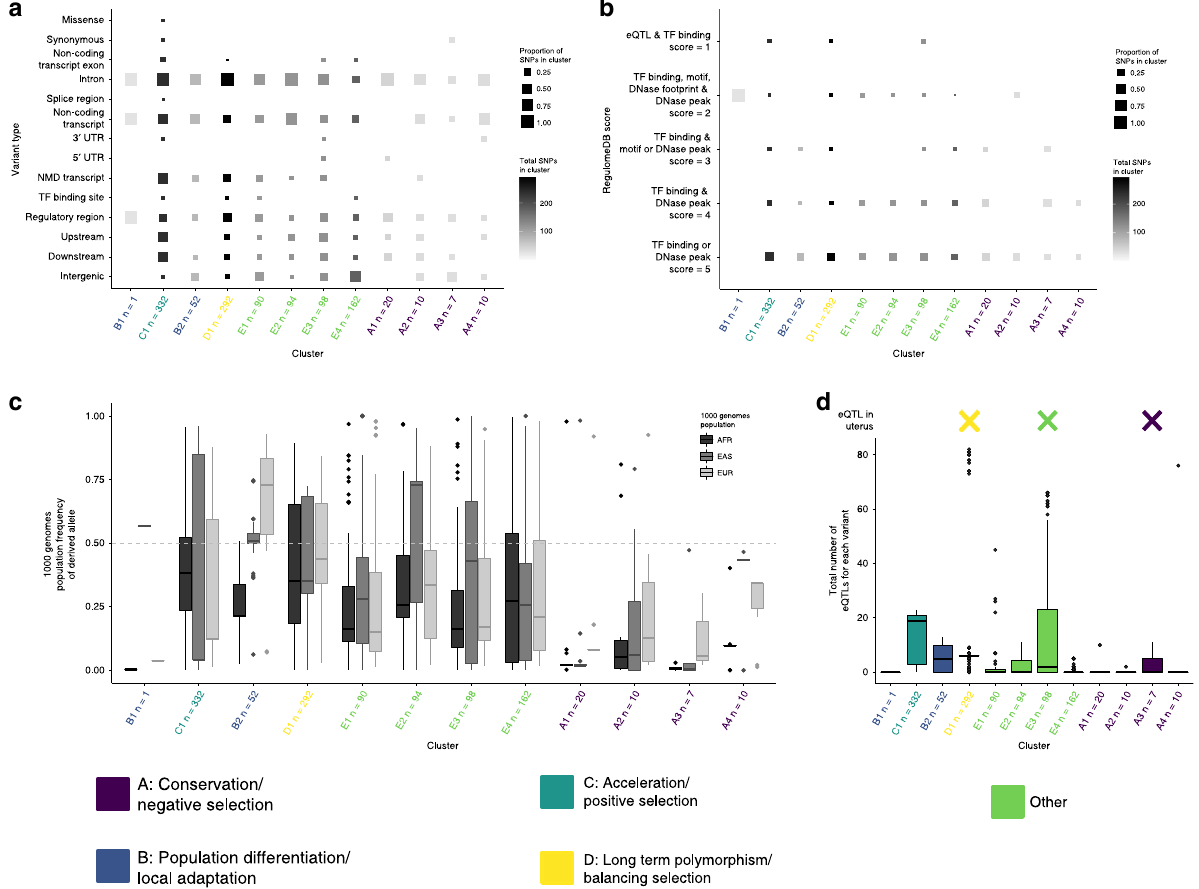
Fig. 3 Groups of sPTB regions vary in their molecular characteristics and functions. Clusters are ordered as they appear in the z-score heatmap (Fig. 2) and colored by their major type of selection: Group A: Conservation and negative selection (Purple), Group B: Population differentiation/local adaptation (Blue), Group C: Acceleration and positive selection (Teal), Group D: Long-term polymorphism/balancing selection (Teal), and Other (Green). All boxplots show the mean (horizontal line), the fi rst and third quartiles (lower and upper hinges), 1.5 times the interquartile range from each hinge (upper and lower whiskers), and outlier values greater or lower than the whiskers (individual points). a The proportions of different types of variants (e.g., intronic, intergenic, etc.) within each cluster ( x -axis) based on the Variant Effect Predictor (VEP) analysis. Furthermore, cluster C1 exhibits the widest variety of variant types and is the only cluster that contains missense variants. Most variants across most clusters are located in introns. b The proportion of each RegulomeDB score ( y -axis) within each cluster ( x -axis). Most notably, PTB regions in three clusters (B1, A5, and D4) have variants that are likely to affect transcription factor binding and linked to expression of a gene target (Score = 1). Almost all clusters contain some variants that are likely to affect transcription factor binding (Score = 2). c The derived allele frequency ( y -axis) for all variants in each cluster ( x -axis) for the African (AFR), East Asian (EAS), and European (EUR) populations. Population frequency of the derived allele varies within populations from 0 to fi xation. d The total number of eQTLs ( y -axis) obtained from GTEx for all variants within each cluster ( x -axis) All clusters but one (C2 with only one variant) have at least one variant that is associated with the expression of one or more genes in one or more tissues. Clusters A1, A5, and D4 also have one or more variants associated with expression in the